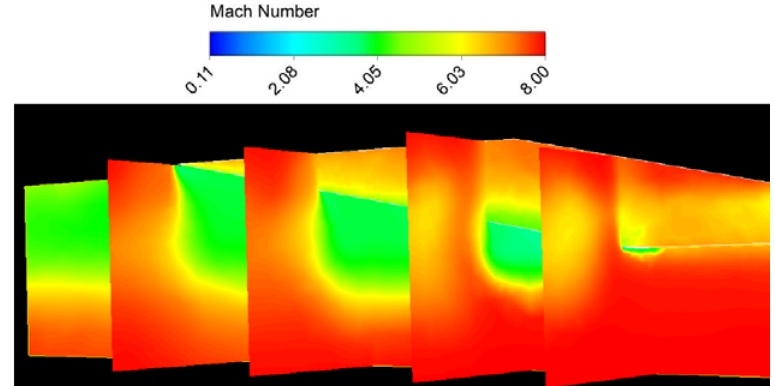
Figure 27. Velocity and density streamlines of the scramjet engine.